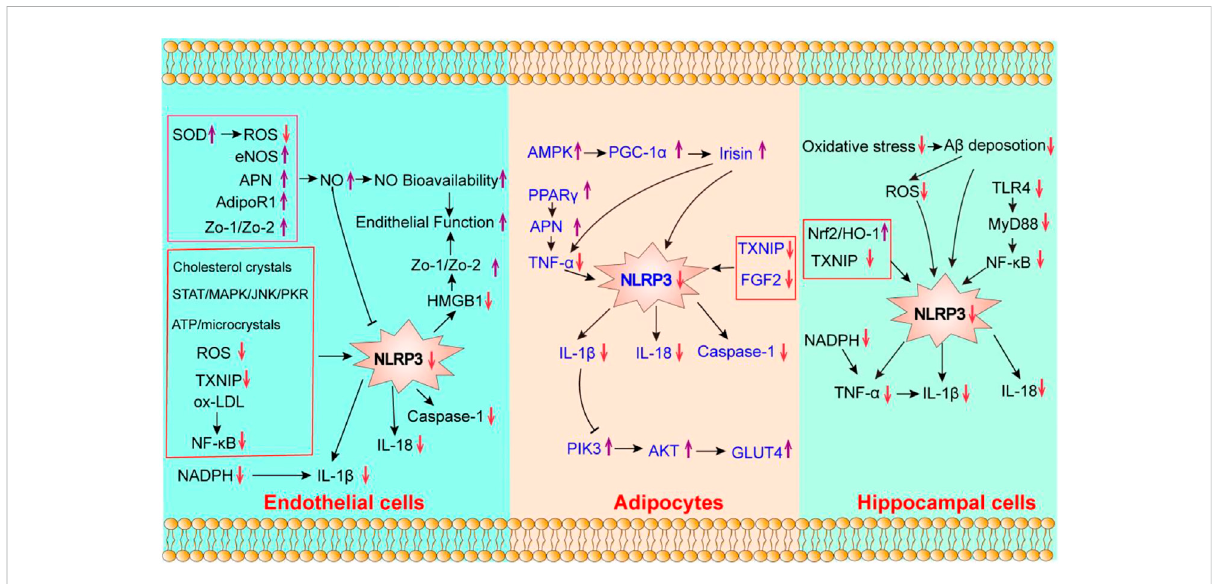
Thepotentialeffectofaerobicexerciseonthepyroptosisofendothelialcells,adipocytesandhippocampalcells. “ ↓ ” indicatesthatitsexpression can be downregulated by aerobic exercise; “ ↑ ” indicates that it can be enhanced by aerobic